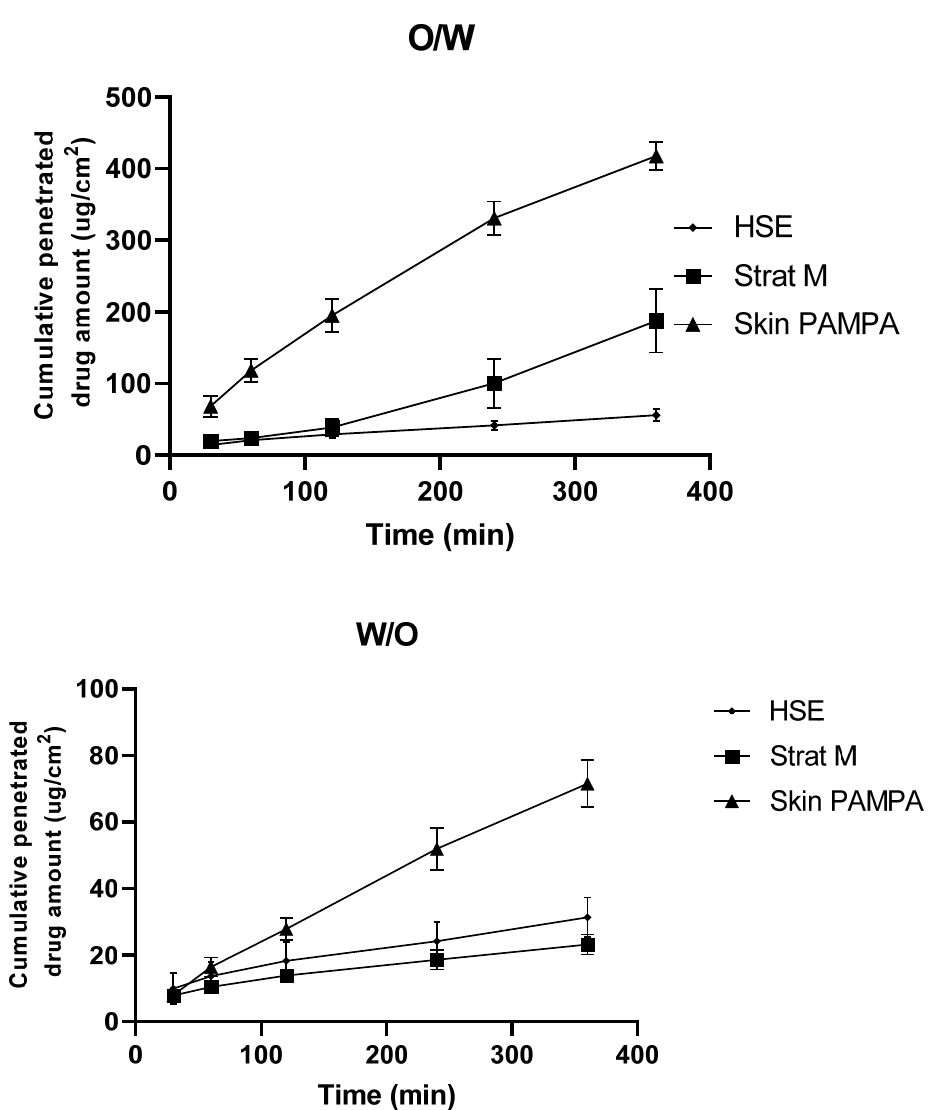
Figure 1. Permeation profile of different formulations using different membranes. Data represent mean and standard deviation.